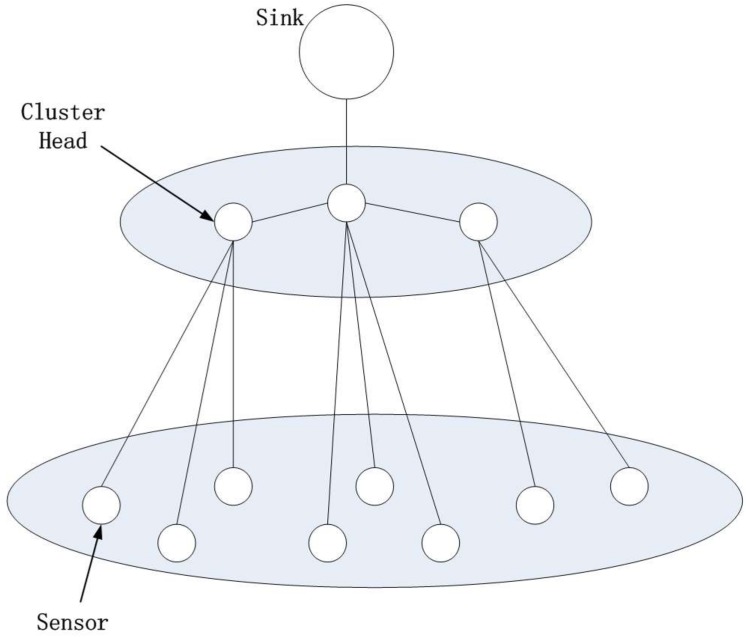
Cluster-based WSN.